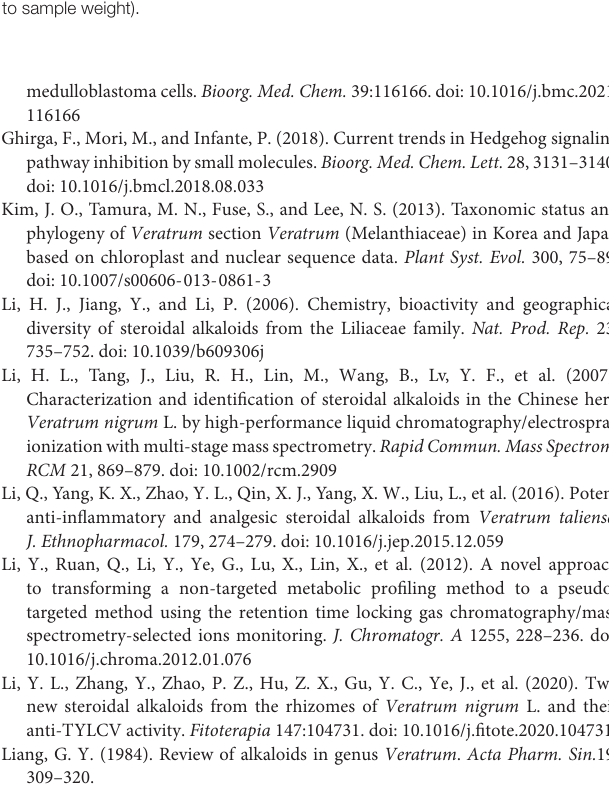
Supplementary Figure 1 | Skeletons of steroidal alkaloids from Veratrum plants. Supplementary Table 1 | The results of labeled 147